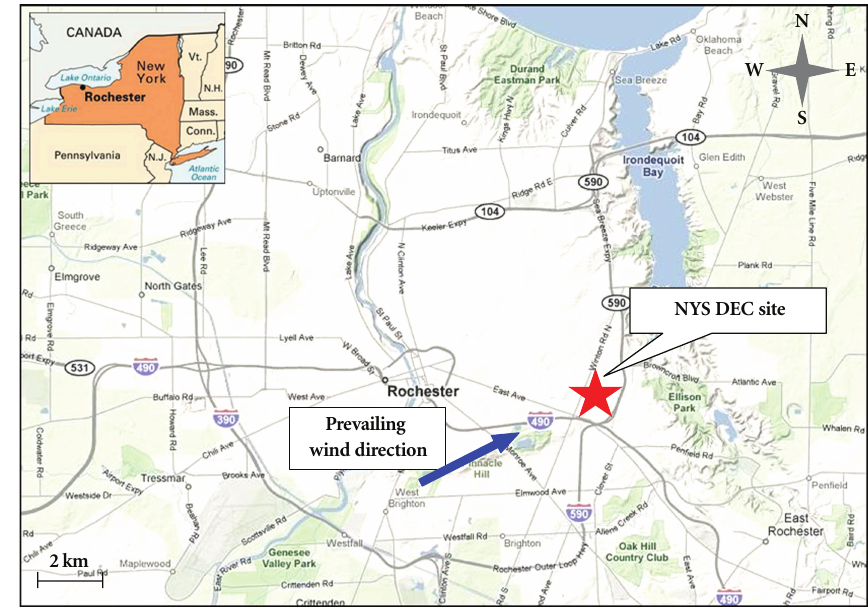
Figure 4: Location of the sampling site in Rochester, NY.